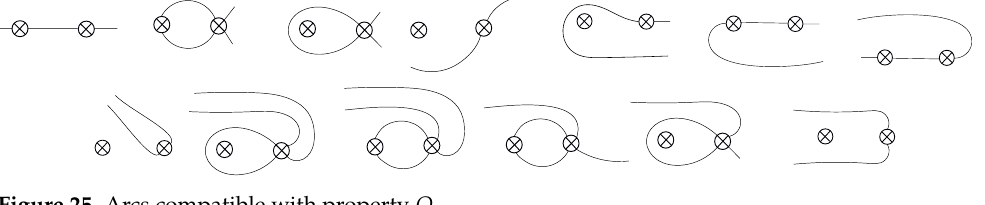
Figure 25. Arcs compatible with property Q